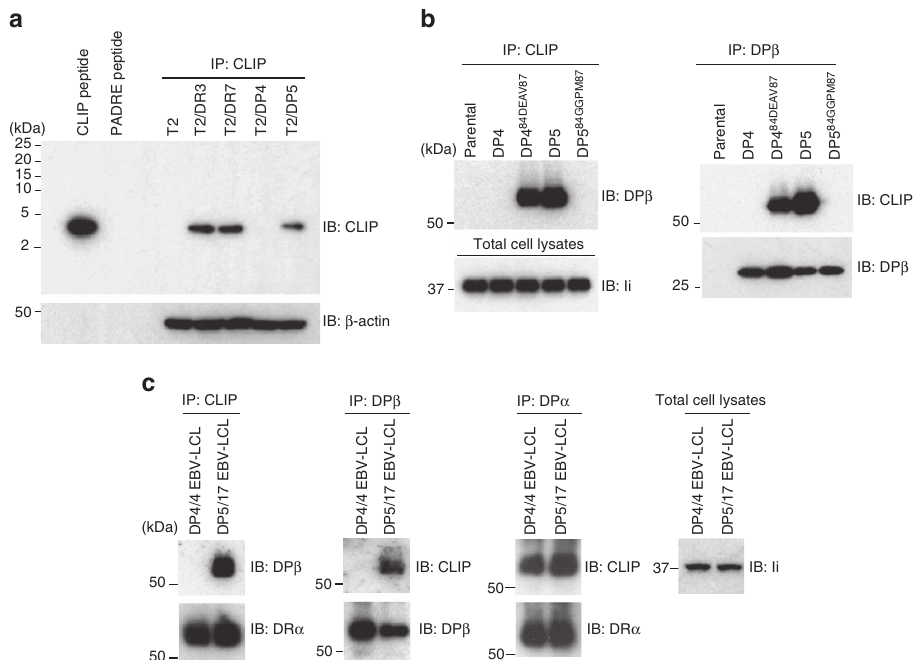
Figure 2 | CLIP is produced by DR and DP5 but not DP4. ( a – c ) Total cell lysates were immunoprecipitated and immunoblotted with indicated mAbs. Total cell lysates were prepared from T2 transfectants expressing the indicated class II as a single class II allele ( a , b ) and EBV-LCL homozygous for